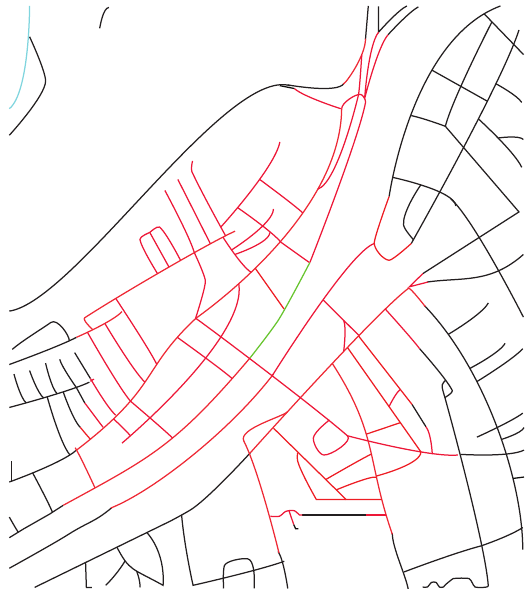
Figure 2: Example of a 500 m accessibility analysis. The green line corresponds to the “origin”, while all red lines show the area covered by a 500 m walk from it. Source: own